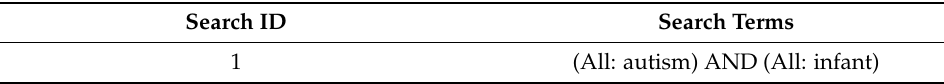
Table A4. Association for Computing Machinery (ACM) search terms.